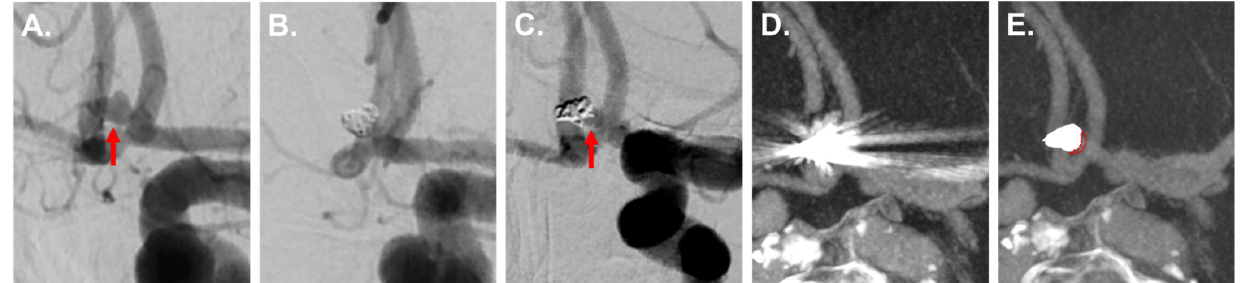
Figure 3. An 84 ‐ year ‐ old patient with an aneurysm of the anterior communicating artery in the ini ‐ tial DSA (( A ) red arrow) with consecutive treatment via endovascular coiling ( B ). Six months later, DSA control revealed a reperfusion at the aneurysm base (( C ) red arrow). The aneurysm was not assessable in iMAR − FD ‐ CTA due to severe metal artifacts ( D ). Thanks to a significant metal artifact reduction, iMAR+ FD ‐ CTA also demonstrated the basal aneurysm reperfusion in accordance with the DSA (( E ) marked with red dotted line).